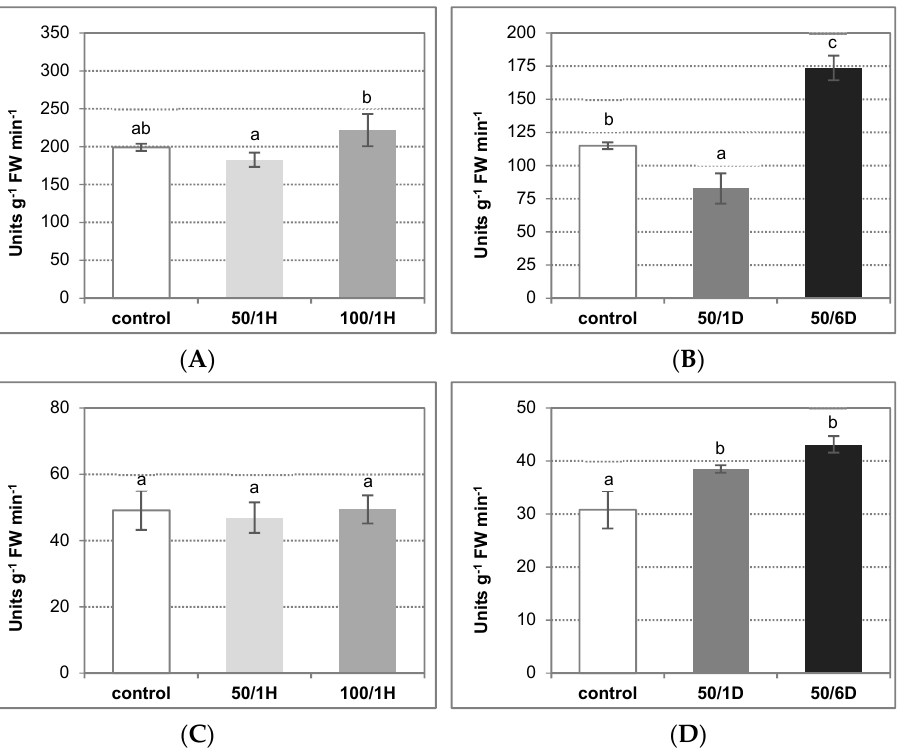
Figure 6. Catalase ( A , B ) and ascorbate peroxidase ( C , D ) activity in the tissues of cucumber roots exposed to salinity. The cucumber seedlings were treated with: ( A , C ) 50 mM or 100 mM NaCl for 1 h (50/1H and 100/1H, respectively); ( B , D ) 50 mM NaCl for 1 or 6 days (50/1D and 50/6D, respectively). The activities of antioxidant enzymes were determined in the roots, as described in Materials and Methods. The presented results are the means ± SD of three independent experiments, each run in triplicate, and are expressed as units g − 1 FW min − 1 . Different letters show different homogeneous groups of means calculated by Duncan’s multiple range test (significant at p < 0.05).